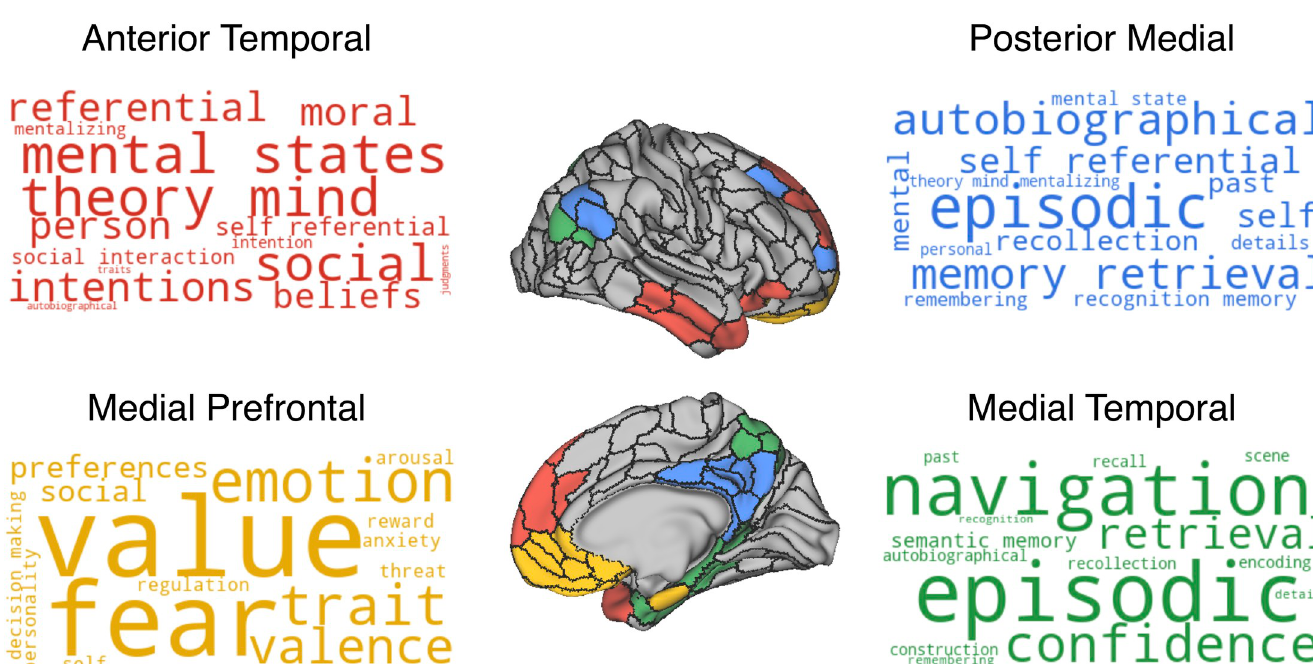
Fig 7. Terms associated with activation of each cortico-hippocampal network. Word clouds are colored according to the network they describe which are displayed on the inflated brain. The size of the terms in the word cloud relates to how strongly the meta-analytic activity of that term correlates with the spatial extent of the network. Red, AT subnetwork; Blue, PM subnetwork; Yellow, MP subnetwork; Green, medial temporal network. Data can be found at https://github.com/ajbarn/ hippo_nets.